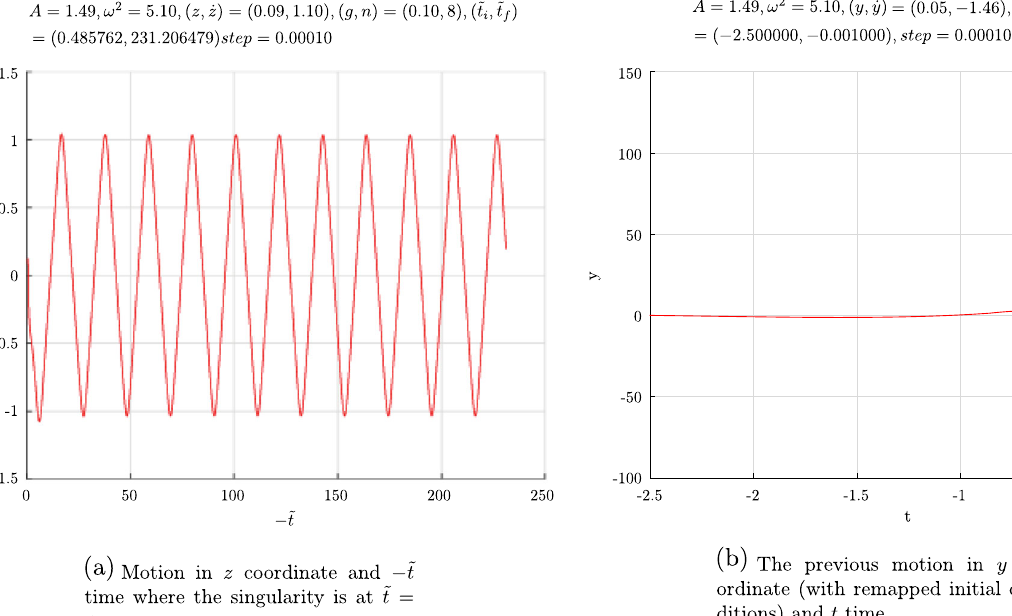
Fig. 3 Classical motion with α > 0